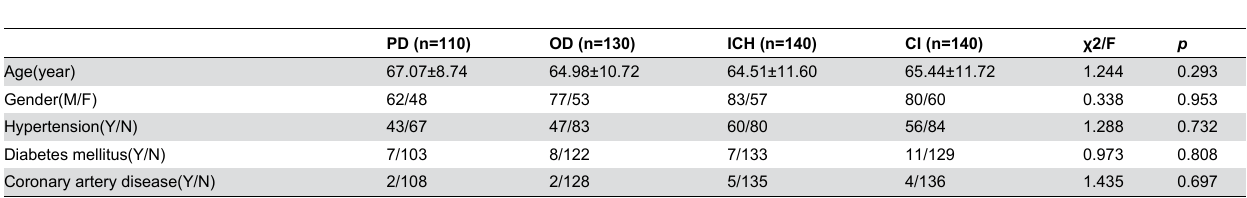
Table 1. The demographics, history of coronary artery disease, hypertension, diabetes mellitus of the four